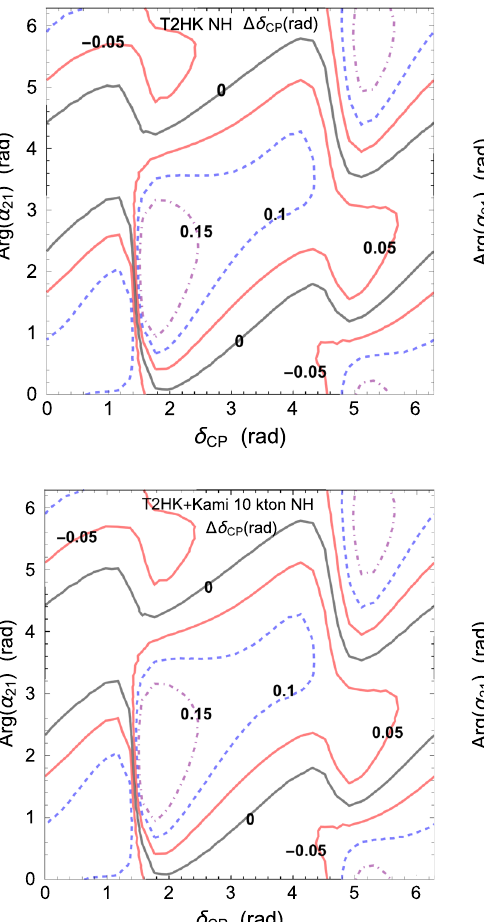
Cerenkov detector at Oki, respectively. For comparative study, we show in the lower-left a subplot for a plan of the T2HK plus a 10 kton water Cerenkov detector at Kamioka. | (cid:10)δ CP | = 0 , 0 . 05rad , 0 . 1rad, and 0 . 15rad on the black solid, red sold, blue dashed, and purple dot-dashed contours,